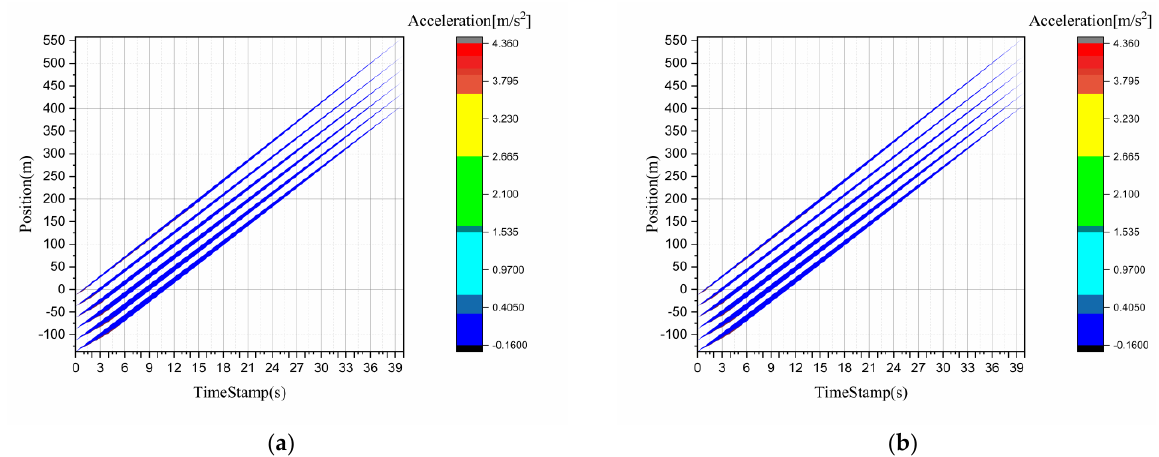
Figure 12. Velocity heatmap of CAVF fleet and CACCNF fleet under scenario 2: ( a ) CAVF velocity heatmap; ( b ) CACCNF velocity heatmap.